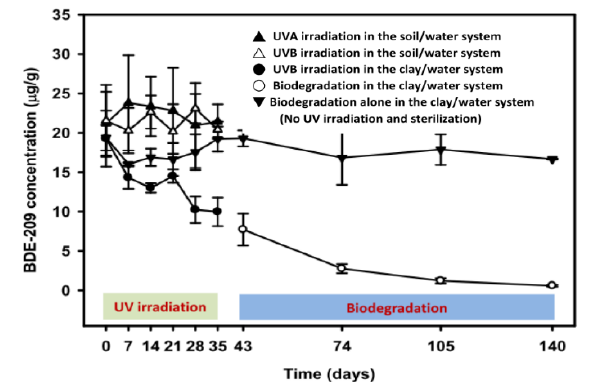
Figure 2. The concentration of decabrominated diphenyl ether (BDE-209) after the sequential treatment with photolysis and biodegradation in the SSR system.